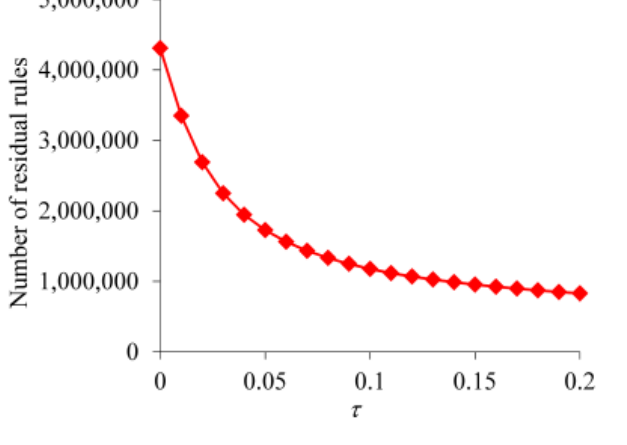
Figure 1. The number of residual rules versus the confidence difference threshold τ